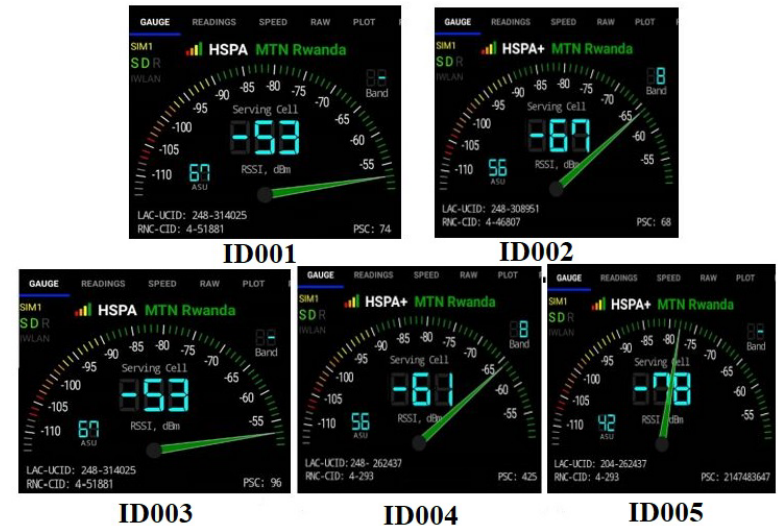
Figure 6. Various RSSI by location and operator